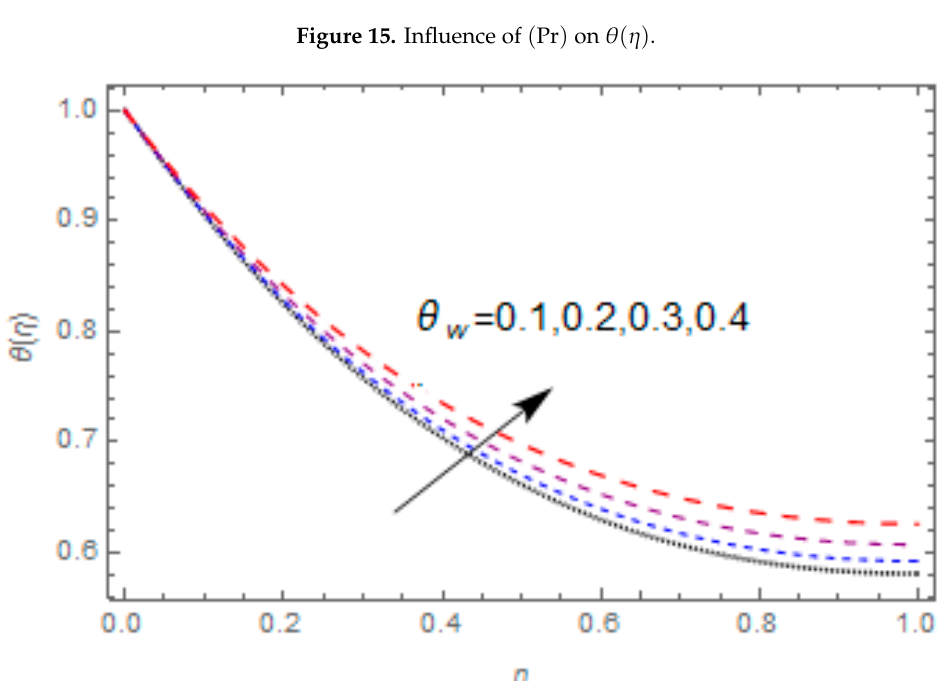
Appl. Sci. 2019 , 9 , x FOR PEER REVIEW 16 of 20